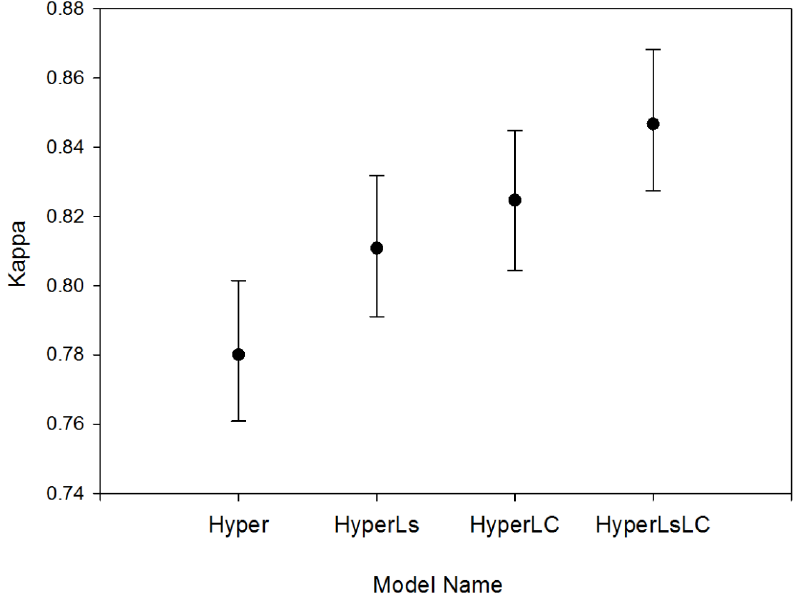
Figure A1. The 2005 Landsat-based land cover map used as part of the multitemporal forest regrowth classification in this study. The red outline denotes the San Juan-La Selva Biological Corridor, and the white outline denotes the outer boundary of the HyMap land-use map (see Figure 8). Non-native tree plantations are shown in purple, and native reforestation (including secondary forest and native tree plantations) is shown in green; all other land cover classes are defined in Table 2.